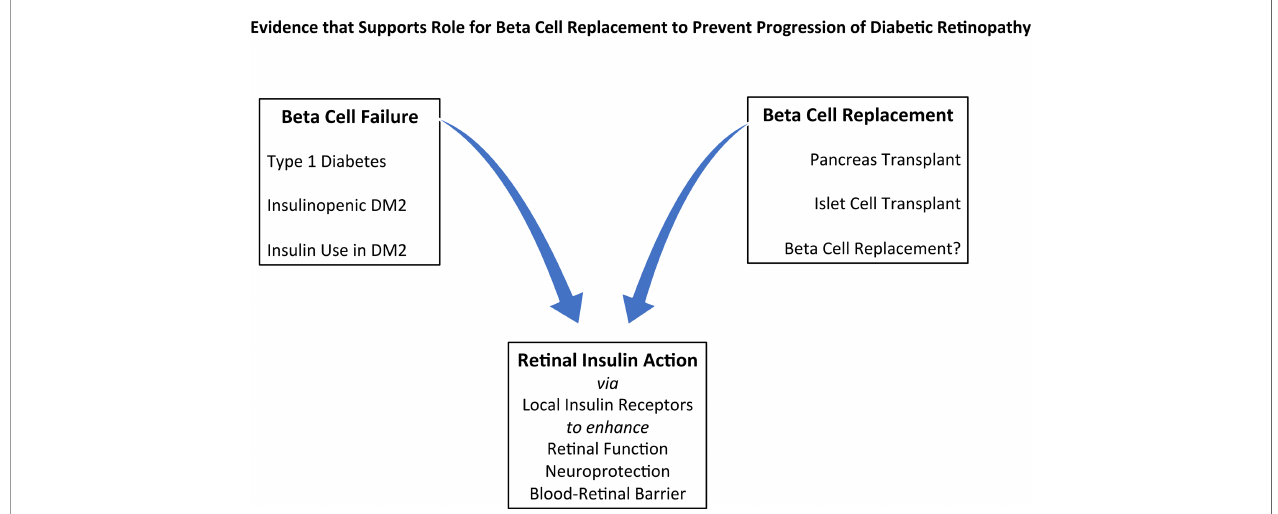
FIGURE 1 | Evidence that Supports a Role for Beta Cell Replacement to Prevent Progression of Diabetic Retinopathy: insulin de fi ciency in the role of risk factors, effects of replacement methods, and retinal effects of insulin. DM2 = Type 2